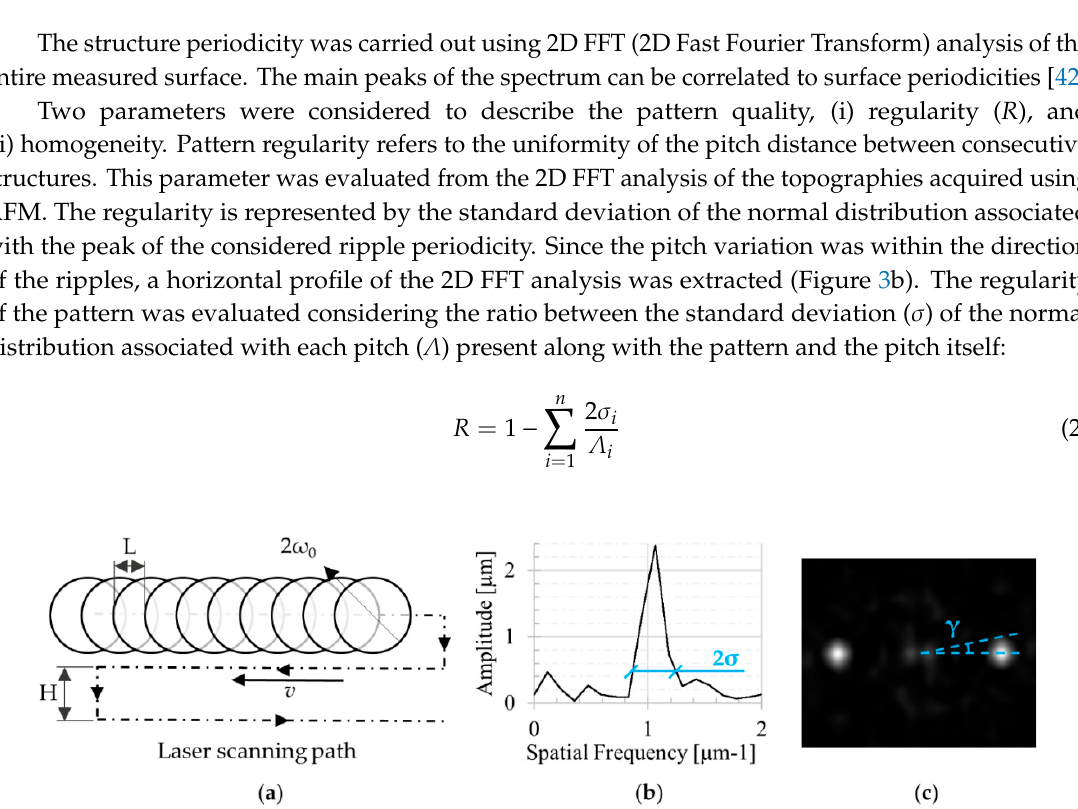
Table 2. AFM measuring setup for the topography of the plastic parts.